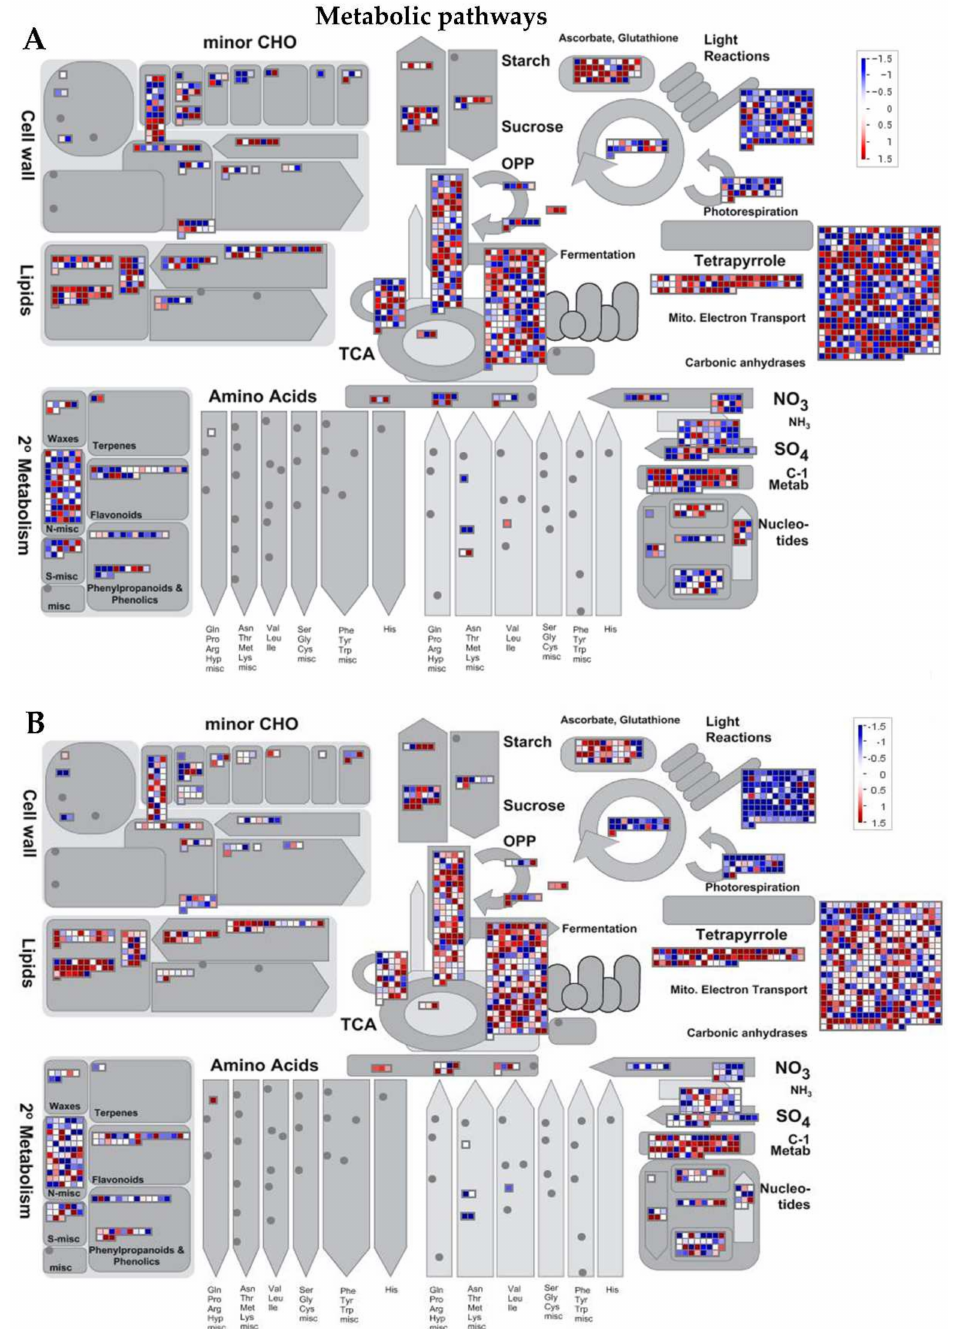
Figure 5. MapMan illustration of differentially changes in transcriptional regulation of metabolic pathways DEGs between Ilpum and NIL in response to GRH infestation. Induction or suppression of the expression of genes involved in different metabolic pathways in ( A ) Ilpum and ( B ) near-isogenic line (NIL) derived from a cross between Ilpum (recurrent parent) and Shingwang (donor parent of Grh1 ), in response to green rice leafhopper (GRH) infestation in rice. Red squares are upregulated genes and blue squares are downregulated genes. Data are logarithm base 2 of fold change (Log 2 FC) (FPKM_value 2/FPKM_value 1). Red boxes are upregulated genes, blue boxes are downregulated genes, and white color indicates Log 2 FC ±